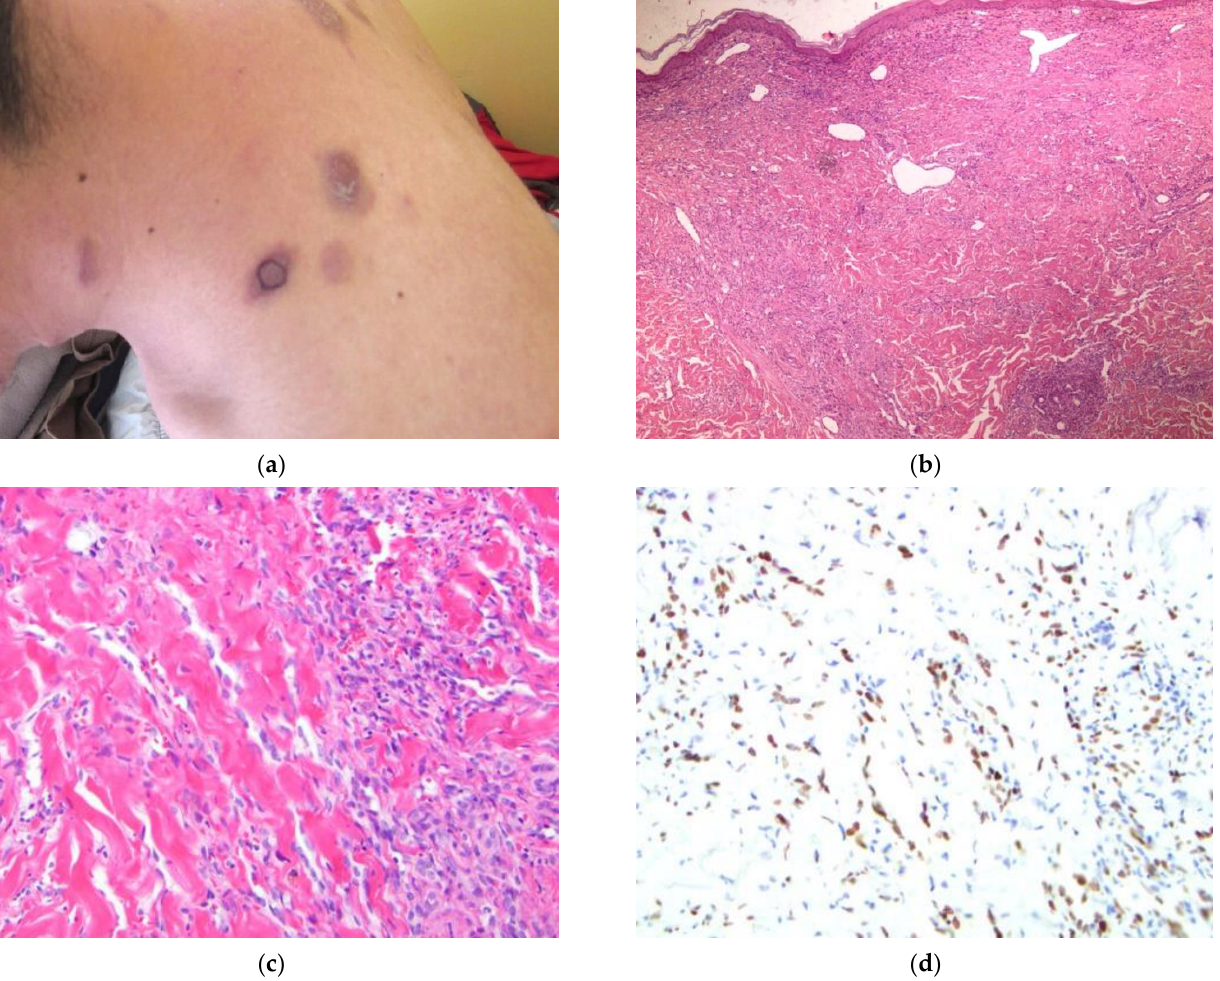
Figure 6. ( a – d ) Patient #6. Image ( a ) Violaceous patches and nodules on the posterior neck and trunk. Biopsy site shown. Image ( b ) H&E 40×. Spindled cells with collagen infiltration, slit-like spaces, and extravasated RBCs. Image ( c ) H&E 200×. Proliferation of spindled cells with slit-like spaces infiltrate into adjacent collagen. Image ( d ) IHC HHV-8 200×. Scattered nuclear staining of spindled cells within the dermis.